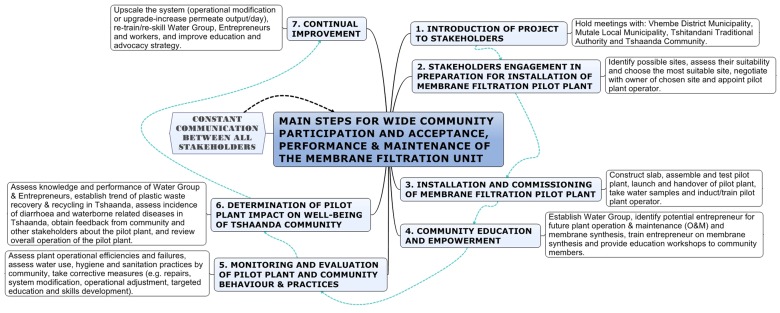
Main steps for wide community participation and acceptance, performance and maintenance of membrane filtration pilot plant.